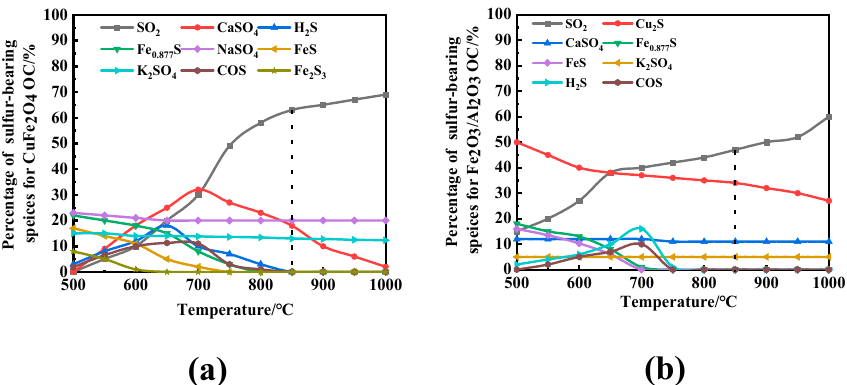
Figure 3. The variation trend of nitrogen-containing substances during coal CLC with ( a ) CuFe 2 O 4 and ( b ) Fe 2 O 3 /Al 2 O 3 with different O/C .